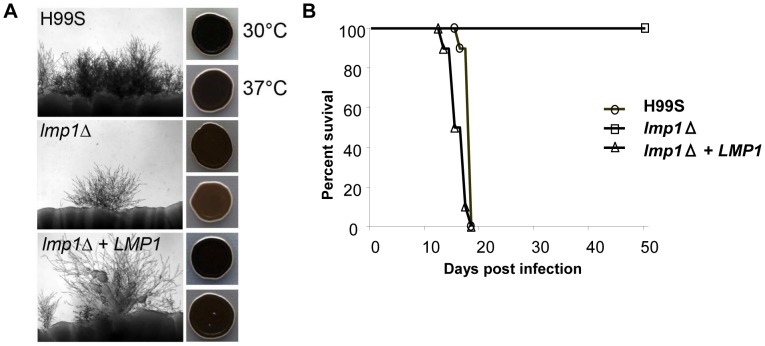
Deletion of LMP1 reduces mating efficiency, melanization and virulence.
A. Mating assays on V8 agar incubated at room temperature for 7 days in the dark. Each strain was mated with KN99a. One or two mating tufts were observed in the lmp1Δ mutant per mating reaction whereas the wild-type and lmp1Δ+LMP1 complemented strain mated robustly. Melanization is reduced in the lmp1Δ mutant at 37°C and restored in the lmp1Δ+LMP1 complemented strain in assays on l–DOPA agar incubated at 30°C or 37°C for 2 days. B. H99S, lmp1Δ mutant strain, and lmp1Δ+LMP1 complemented strain in the murine model of infection. Per each strain, a group of 10 animals was each infected with an inoculum of 5.0×105 cells via intranasal instillation. The results illustrate the complete loss of virulence in the lmp1Δ mutant with the virulence restored back to the H99S level in the lmp1Δ+LMP1 complemented strain.